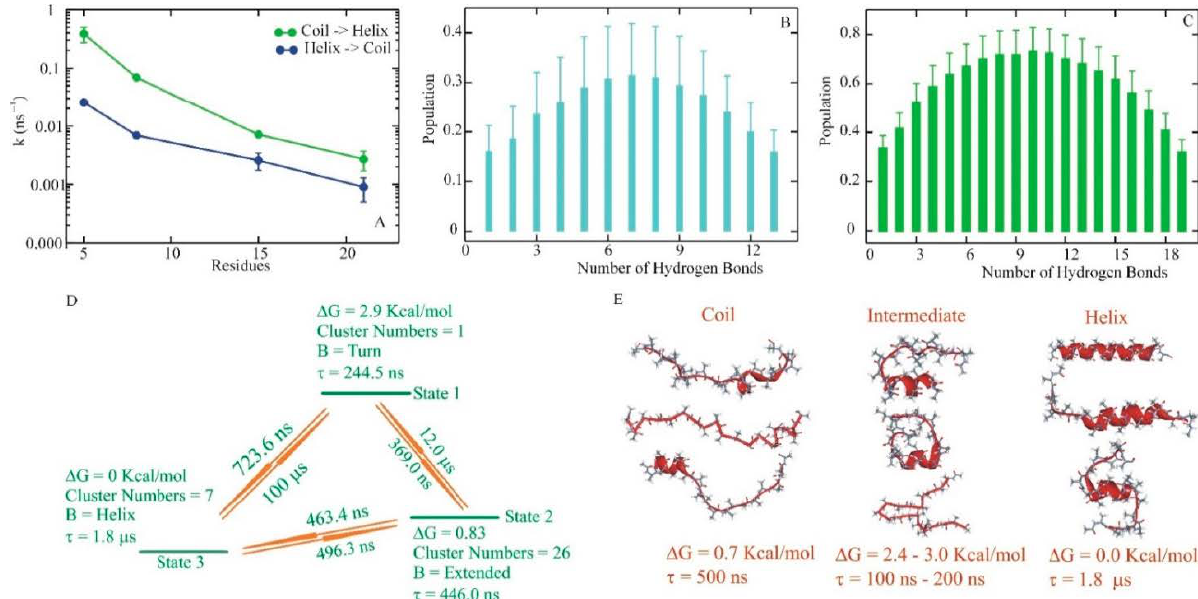
Figure 7. ( A ) Helix–coil kinetics from molecular dynamics simulation. Rates for coil-> helix k f (green) and helix->coil k u (blue) for A5, A8, A15, and A21. ( B , C ) Average helical hydrogen bond populations for A15 and A21. A hydrogen bond is defined as an interaction between the C=O of residue i and NH of residue i + 4. Error analysis provided 95% confidence intervals. ( D ) An example of a coarse-grained kinetic model with N = 3 dimensions for A21, based on N c = 34 initial clusters. ( E ) A summary of the helix, coil, and intermediate structural properties from the aggregated states in ODR models for A21 at various resolutions [87].